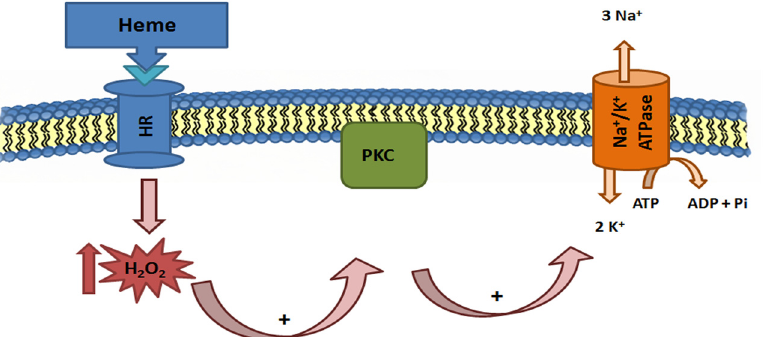
Fig 12. Hypothetical signaling pathway of Na + /K + ATPase activation by increasing H 2 O 2 production through heme and stimulation of the PKC in Leishmania amazonensis promastigotes. HR, heme receptor; H2O2, hydrogen peroxide; PKC, protein kinase C; ATP, adenosine triphosphate; ADP, adenosine diphosphate; Pi, inorganic